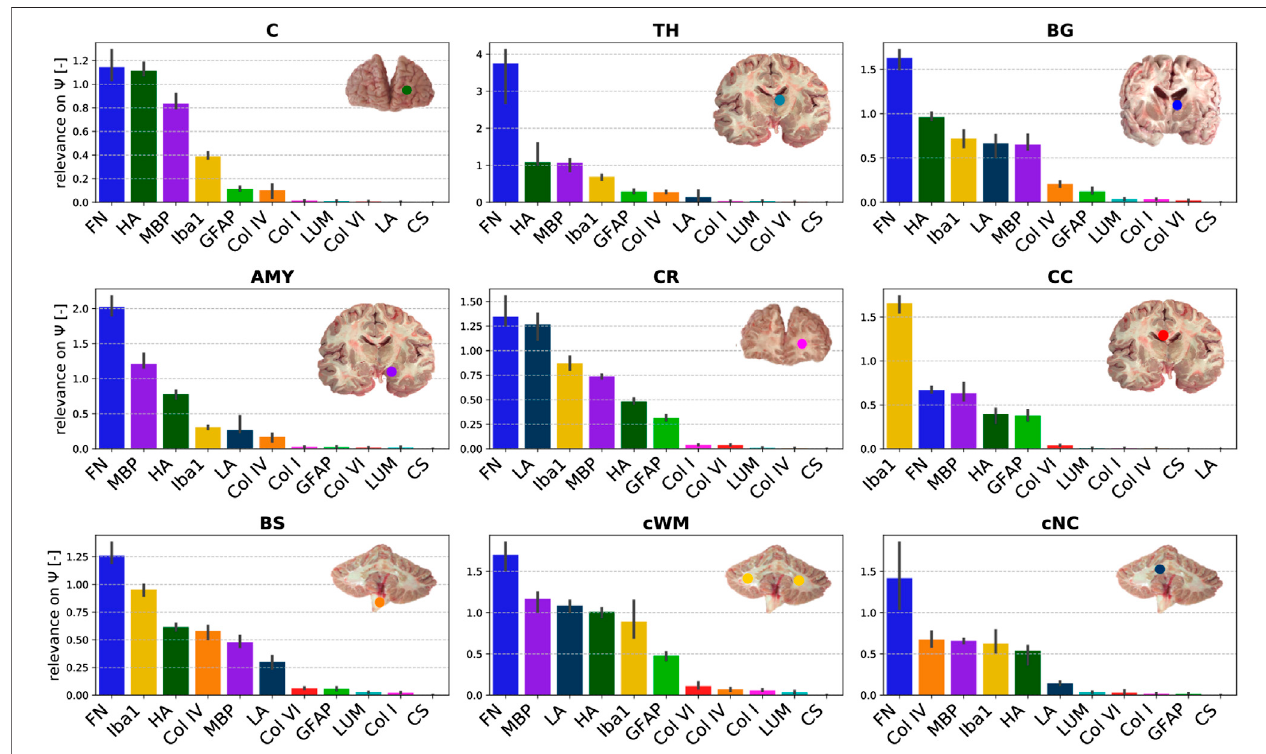
FIGURE 9 | Relevance of the ELISA (see Table 3 ) values for quasi-elastic stress response (determined by Ψ ) different brain regions (see Table 2 ).